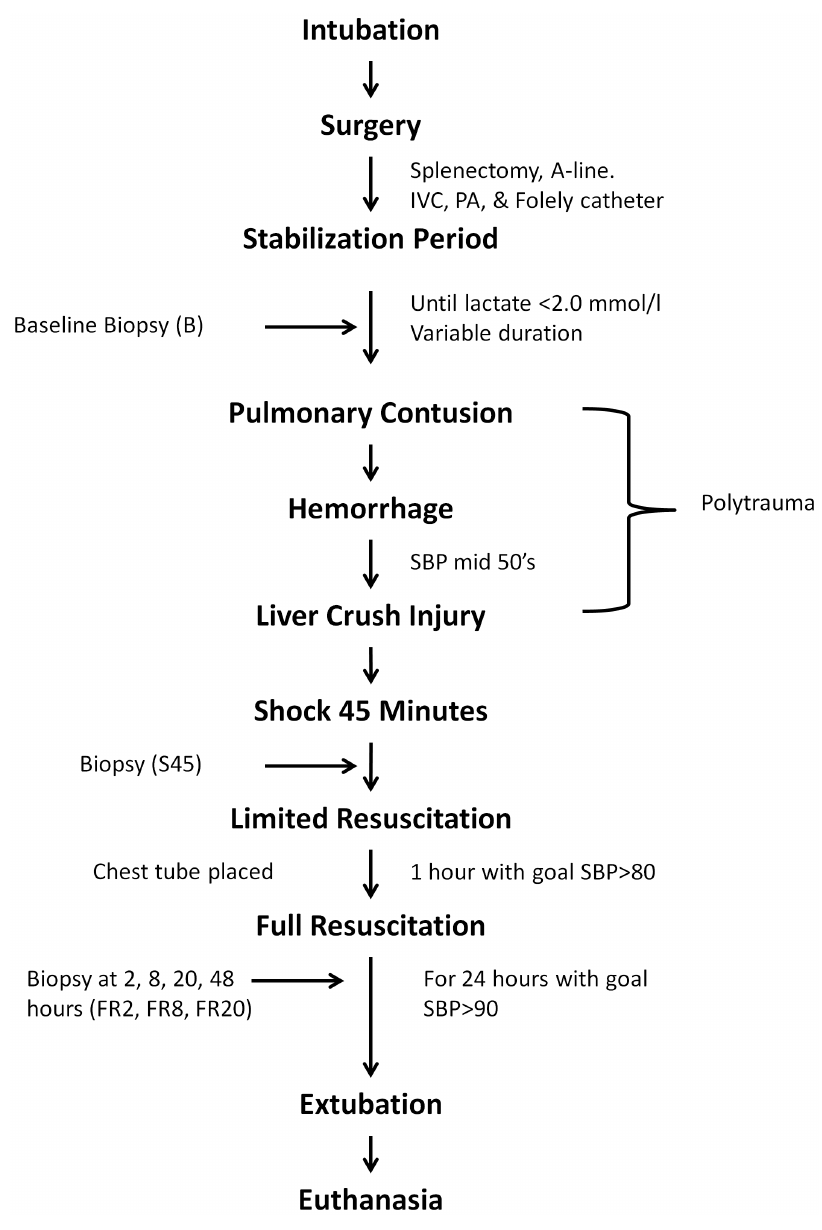
Figure 1. Graphical representation of the experimental timeline described in Methods.